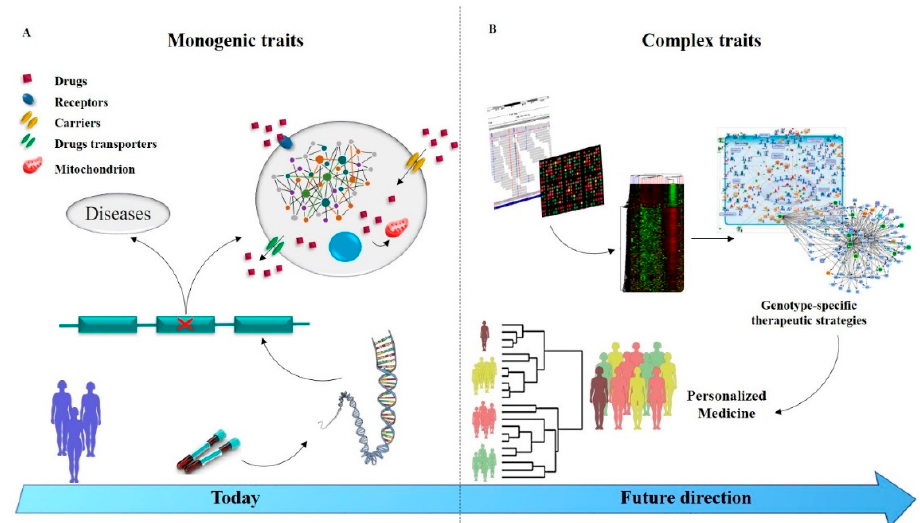
Figure 2. Illustrative representation of pharmacogenomics temporal evolution: from monogenic to complex genetic research analysis. ( A ) Genetic screening tests reveal variants correlated to the etiology of drug resistance in epilepsy. ( B ) Application of genetic technologies (NGS and CGH) integrated together with computational strategies allows the identification of casual disease networks and stratification of patients towards the personalized medicine.